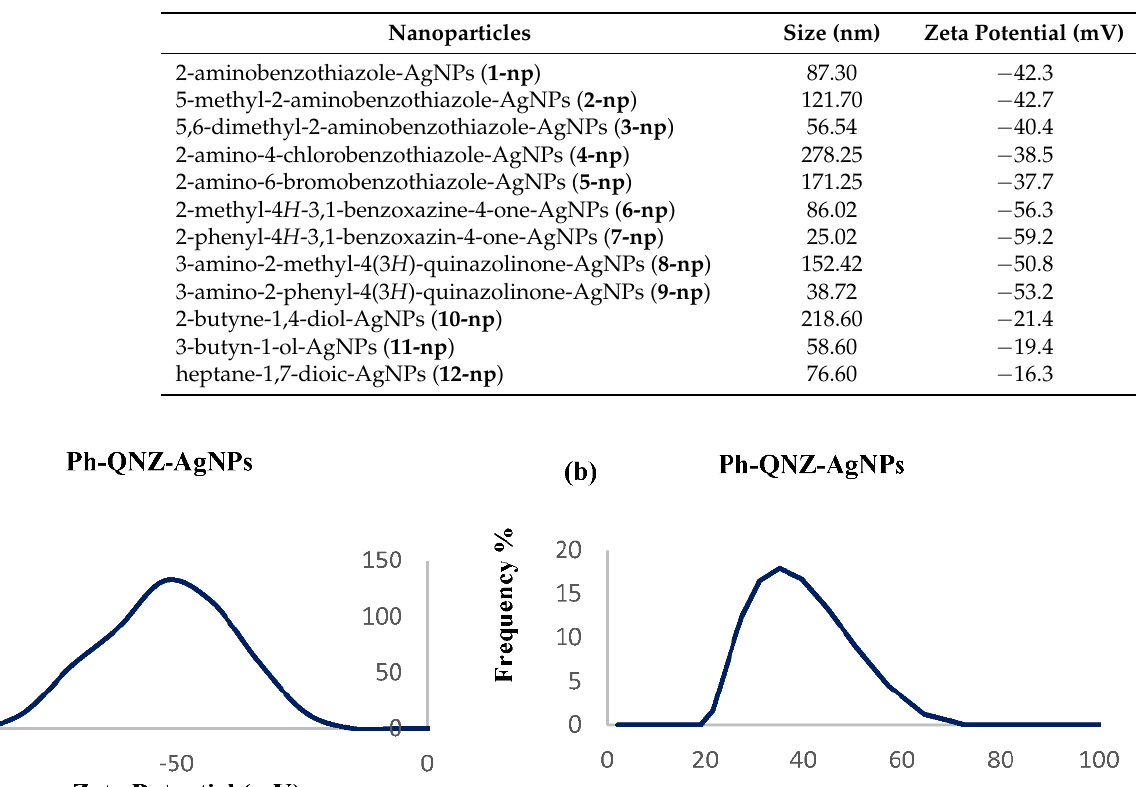
Table 1. Average sizes and zeta potentials for the 12 AgNPs.